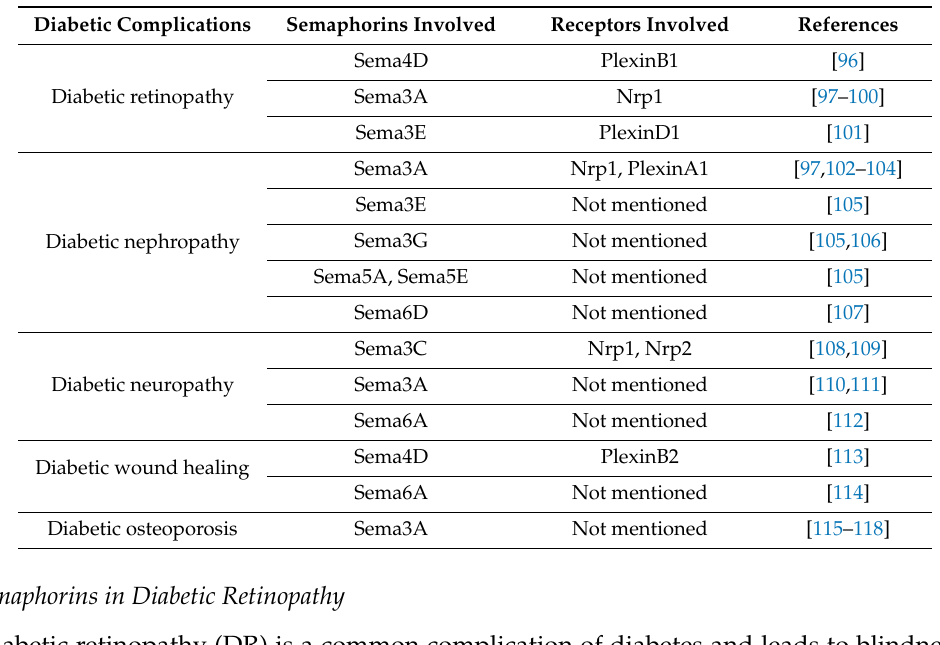
Table 3. Semaphorins in diabetic complications.